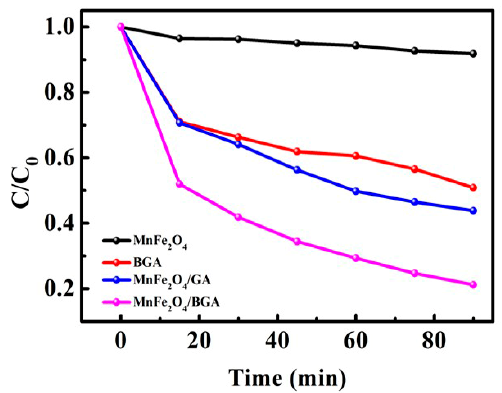
Figure 9. The degradation of RhB on different catalysts in the presence of H 2 O 2 in dark (catalyst dose: 2 mg, volume of 30% H 2 O 2 : 1.0 mL, [RhB]: 10 mg/L, volume of RhB solution: 50 mL).